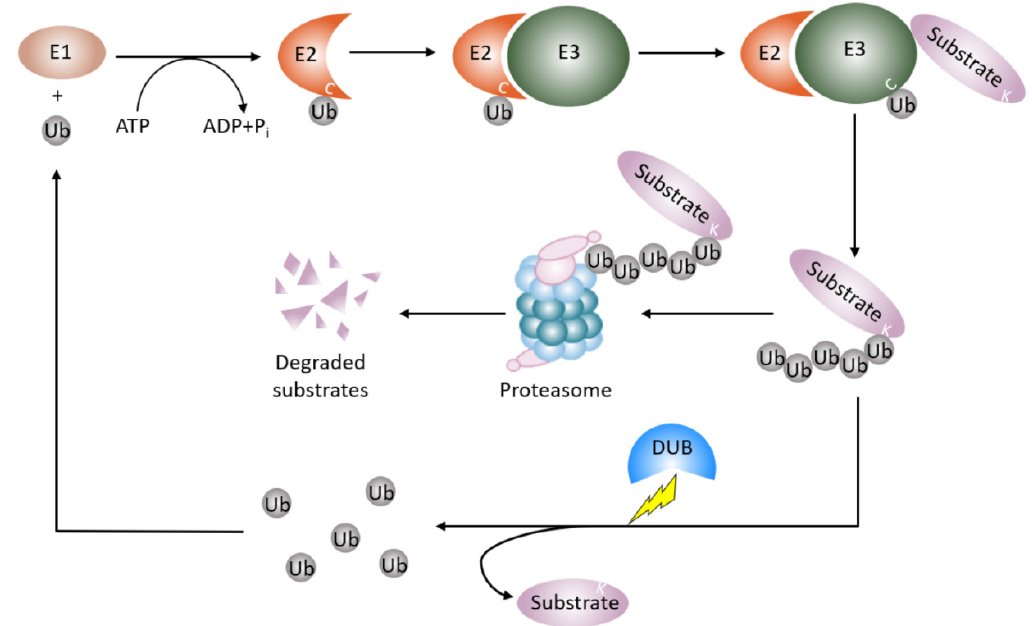
Figure 1. Protein ubiquitin proteasomal degradation and deubiquitination. A protein destined for degradation unleashes a cascade of enzymatic activity involving ubiquitination and proteasomal degradation. E1 Ub-activating enzymes activate ubiquitin and pass the ubiquitin to E2-Ub-conjugating enzymes. E3 Ub-ligases recognize the protein substrates and couple E2-Ub-conjugating enzymes to covalently add the ubiquitin or ubiquitin moieties to the protein substrates. The ubiquitinated proteins are then degraded by the proteasome. Deubiquitinating enzymes remove the mono-ubiquitin or polyubiquitin chains from the ubiquitinated protein to stabilize the protein from proteasomal degradation and recycle ubiquitin units. Ub: ubiquitin; E1: E1 Ub-activating enzyme ； E2: E2-Ub-conjugating enzyme ， E3: E3 Ub-ligases; DUB: deubiquitinating enzyme.